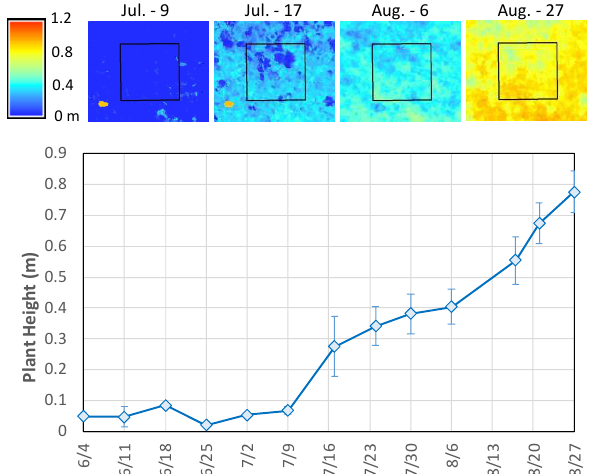
Figure 5. Weekly change of PH (lower) and part of CSM in ROI on 4 days (upper) 3.1.3 Daily relative PPFD and LAI